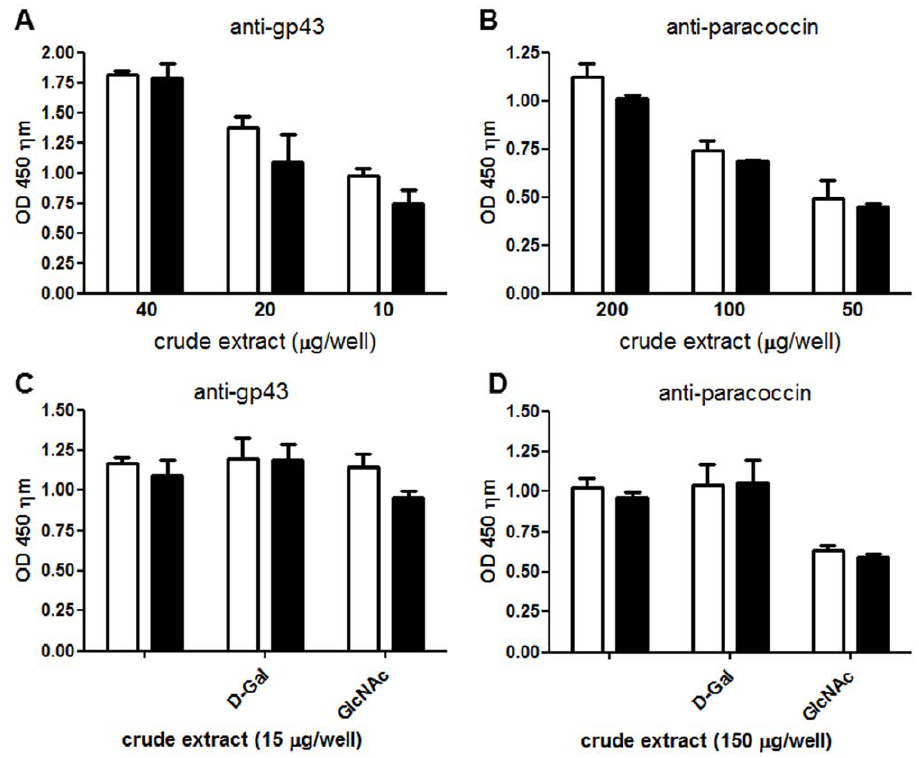
Figure 4. Effect of tunicamycin (TM) on binding of paracoccin and gp43 to laminin. Binding of paracoccin and gp43 to laminin was assayed by incubating different amounts of fully glycosylated and underglycosylated crude extracts (white bars and black bars, respectively) of P. brasiliensis in laminin-coated (0.5 m g/well) microplate wells, followed by incubation with biotinylated monoclonal antibody anti-gp43 (A) or with biotinylated IgY anti-paracoccin (B). The reactions were developed with neutravidin–peroxidase conjugate and H 2 O 2 /OPD substrate. Optical density (OD) readings at 450 nm show dose-dependent binding (A and B). Inhibition assays for gp43 (C) and paracoccin (D) binding to laminin were performed in the presence of 10 mM D -galactose ( D -Gal) or N-acetyl-glucosamine (GlcNAc). Data are representative of 3 independent assays.